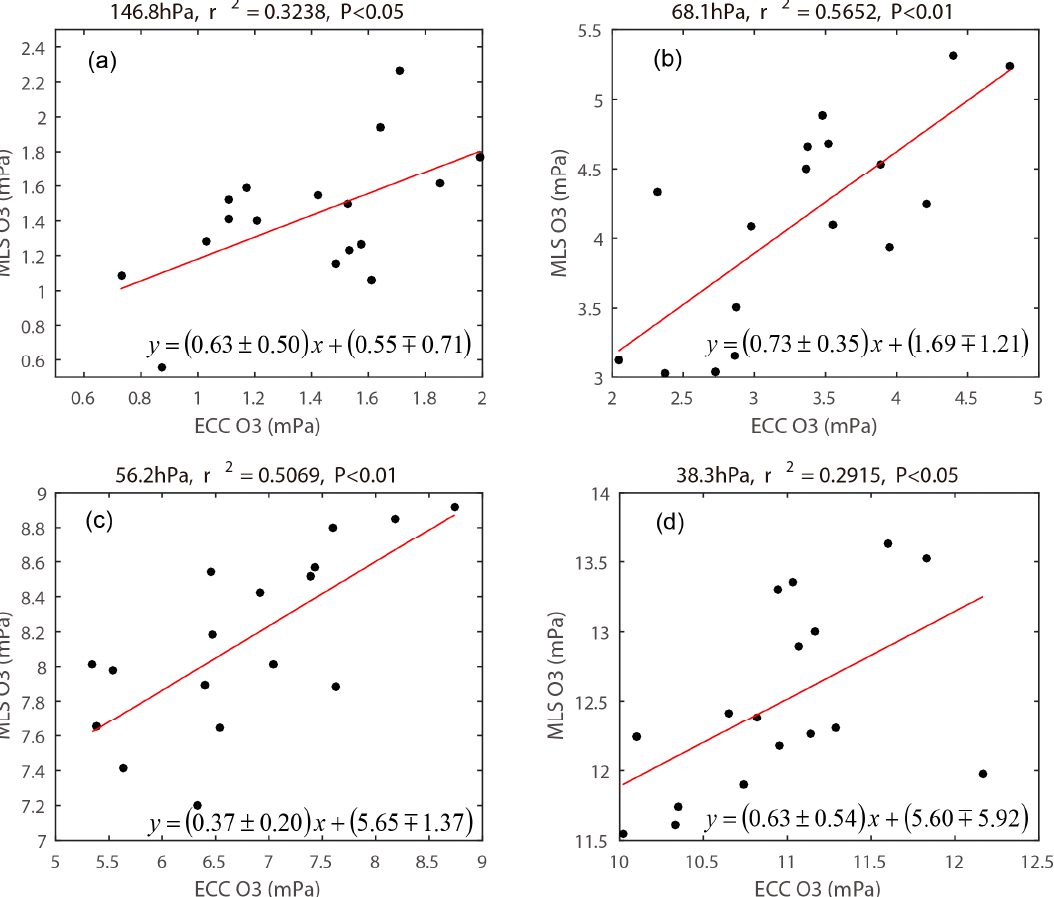
Figure 4. Linear regression relationship between MLS and ozonesonde data in the different layers: ( a ) 146.8 hPa; ( b ) 68.1 hPa; ( c ) 56.2 hPa; ( d ) 38.3 hPa. The interval estimate of the regression coefficient is given according to the 5% significance level.